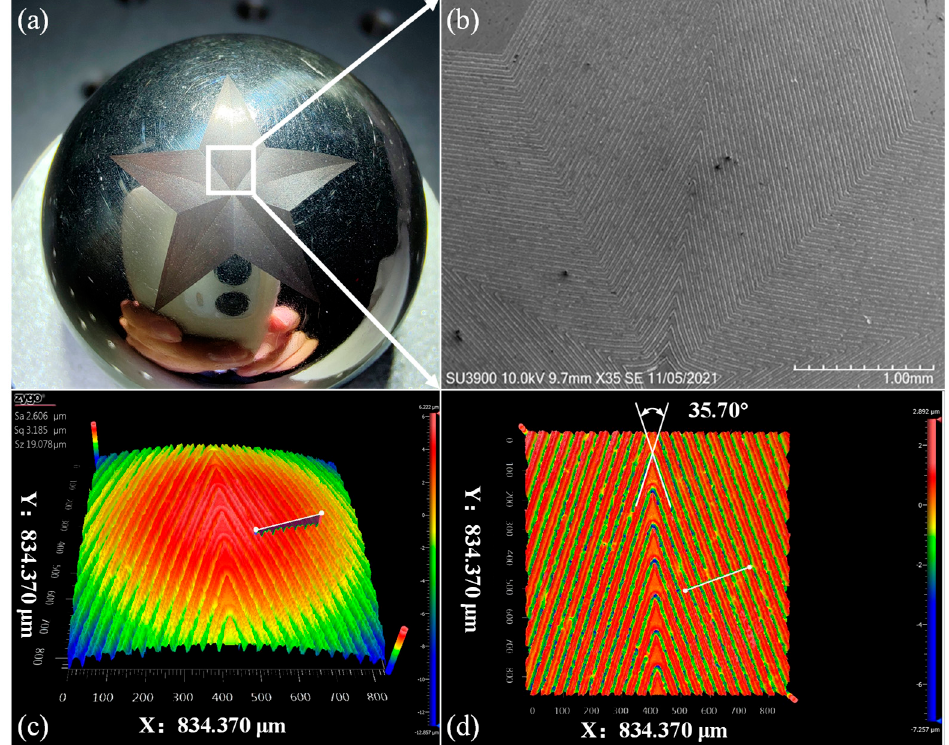
Figure 10. Results of MLAM of pentagonal pattern on stainless steel sphere: ( a ) Global image of the pattern; ( b ) SEM image of magnified ablation area; ( c ) spherical and ( d ) flattened surface morphology characterized by white light interferometer.